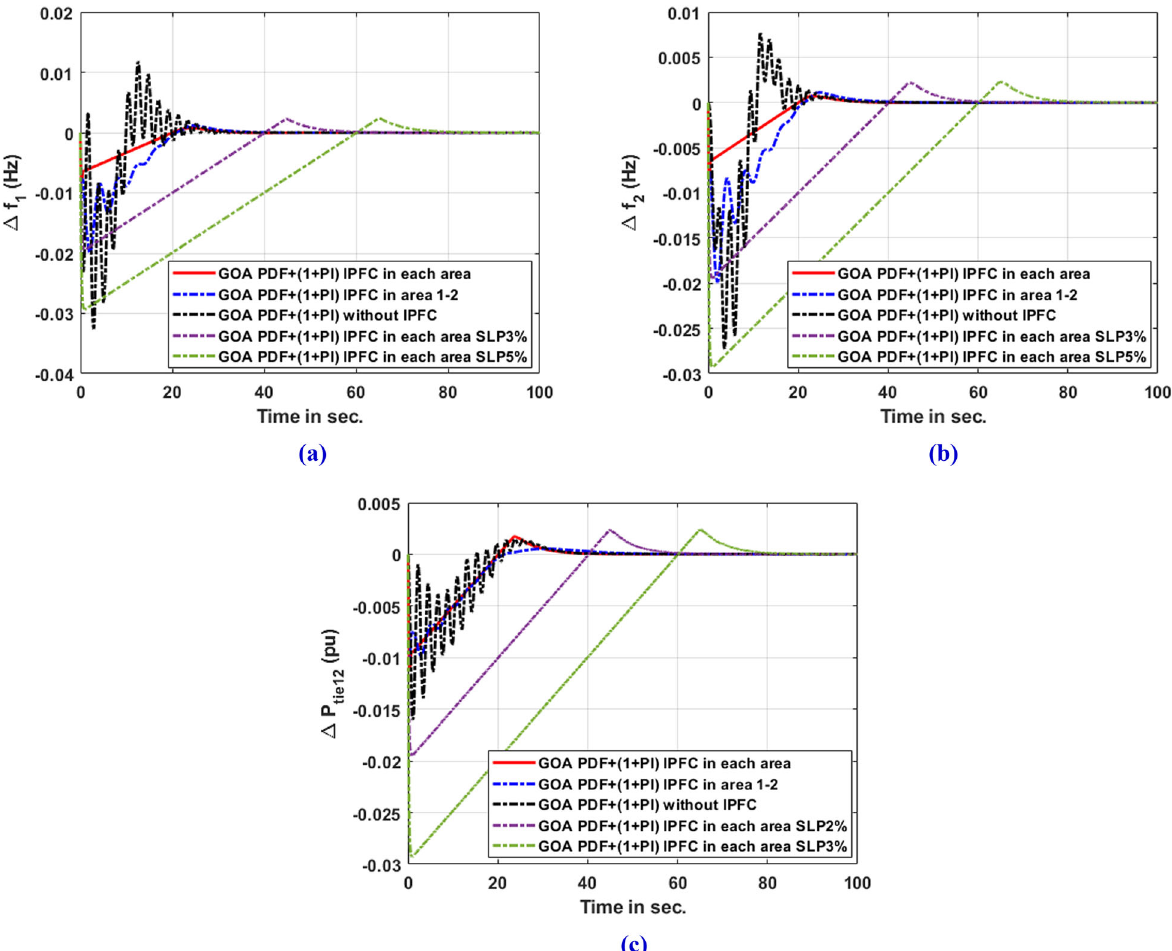
Fig. 10 Dynamic responses of IPFC with different locations and SLP